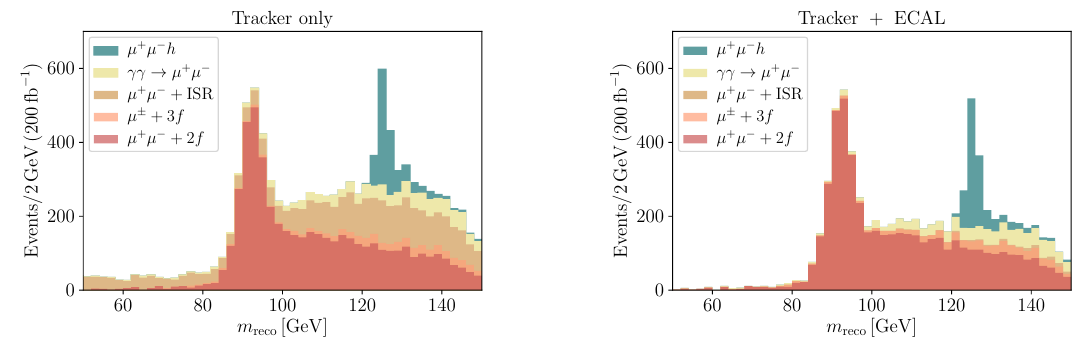
Figure 3 . Distribution of m reco in the di-muon channel for signal and background events with 200 fb (cid:0) 1 after cuts (except that on m reco ) with a tracking detector (left) and a general purpose detector (right) with tracking and electromagnetic calorimeter. The general purpose detector with calorimetry allows veto of hard ISR photons which removes almost all of the two fermion back- ground, and as well allows FSR and muon momenta to be combined to slightly improve kinematic